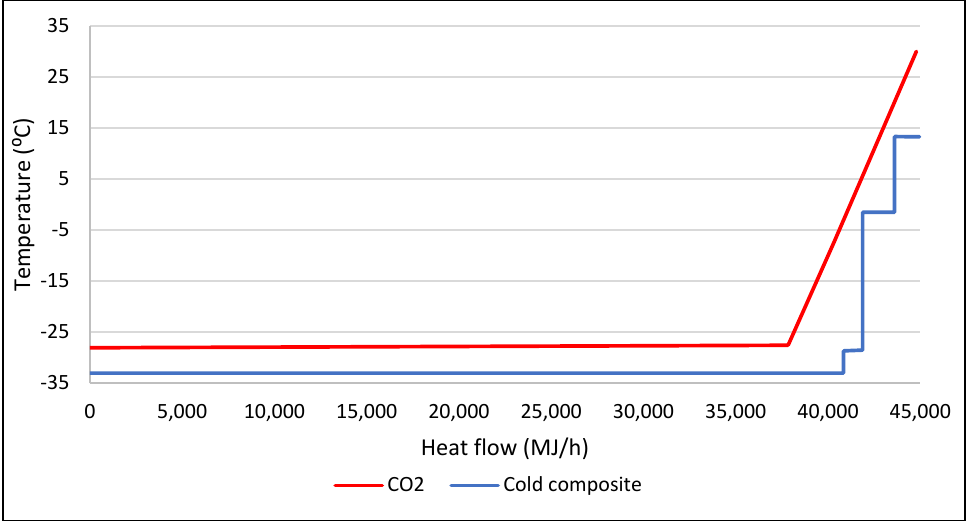
Figure 15. P – H diagram ammonia from 0.5 bar to 100 bar. The black lines illustrate the ammonia refrigeration cycle in configuration 3.